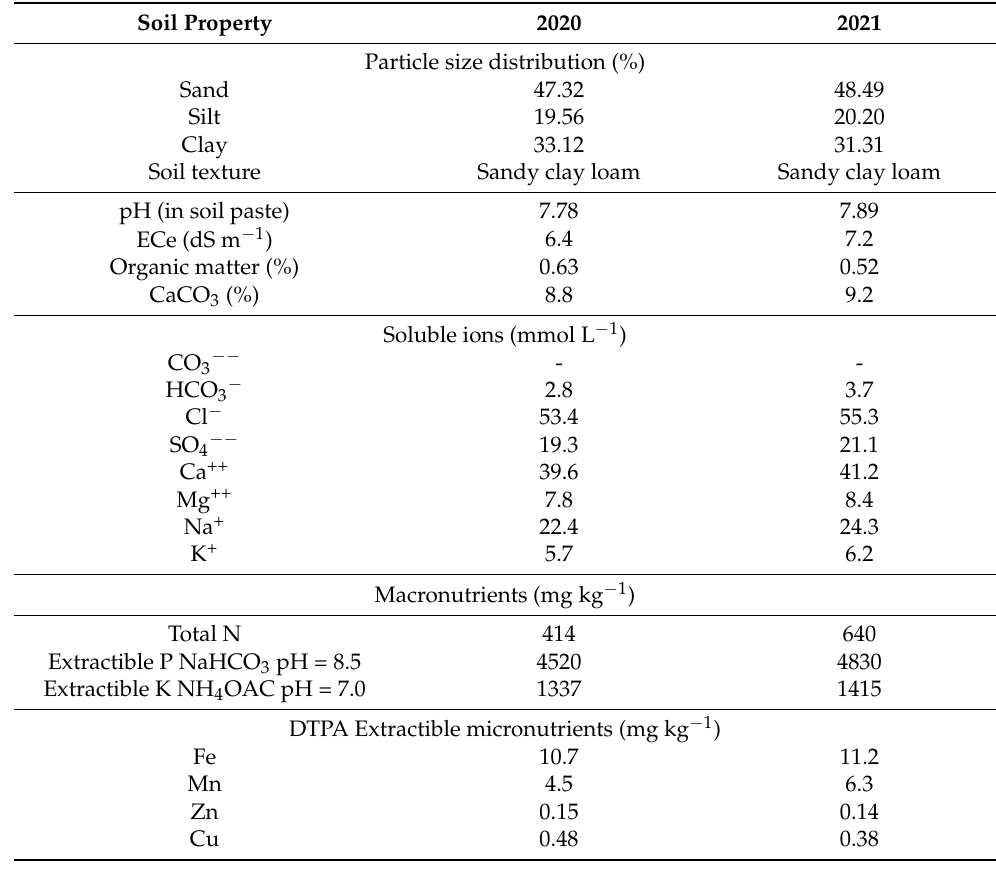
Table 4. Some soil chemical and physical